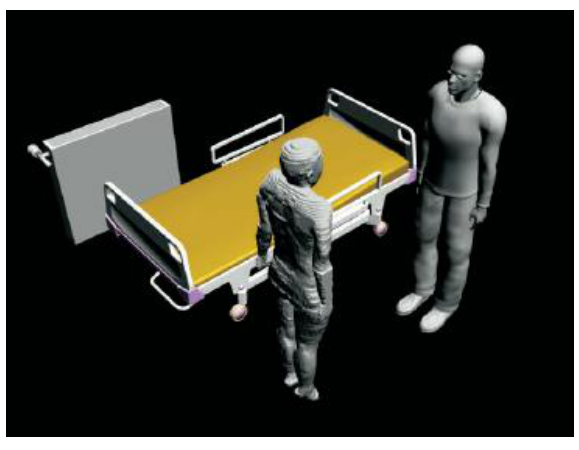
Figure 7. Inter-body propagation case in